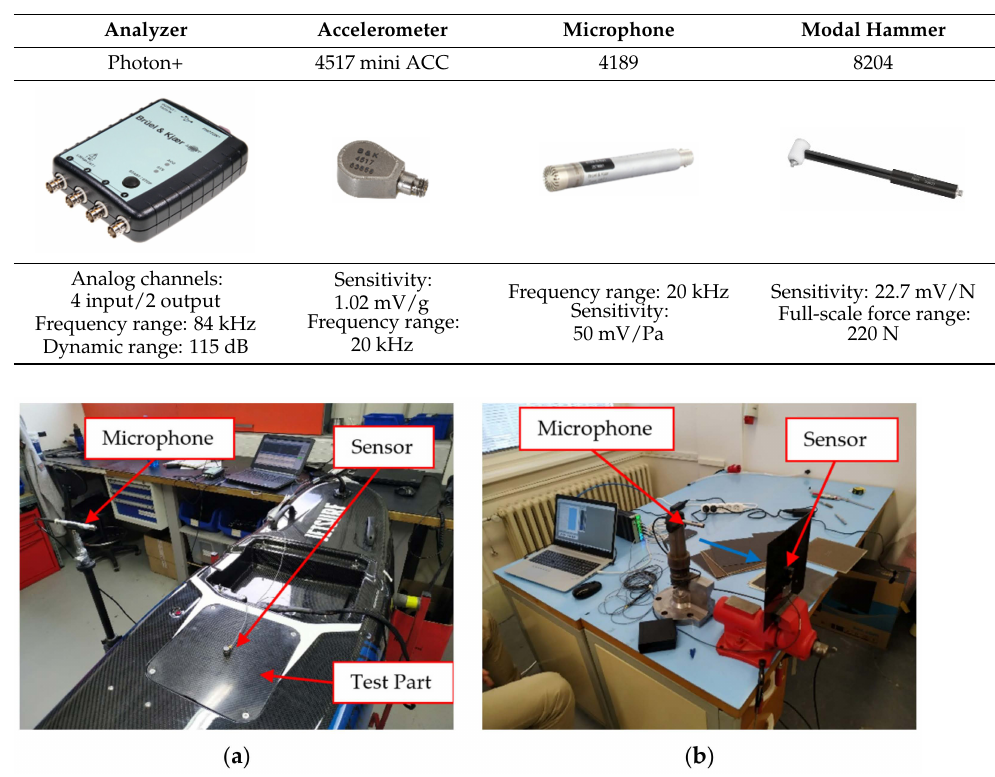
Table 3. Brüel & Kjaer measuring equipment.